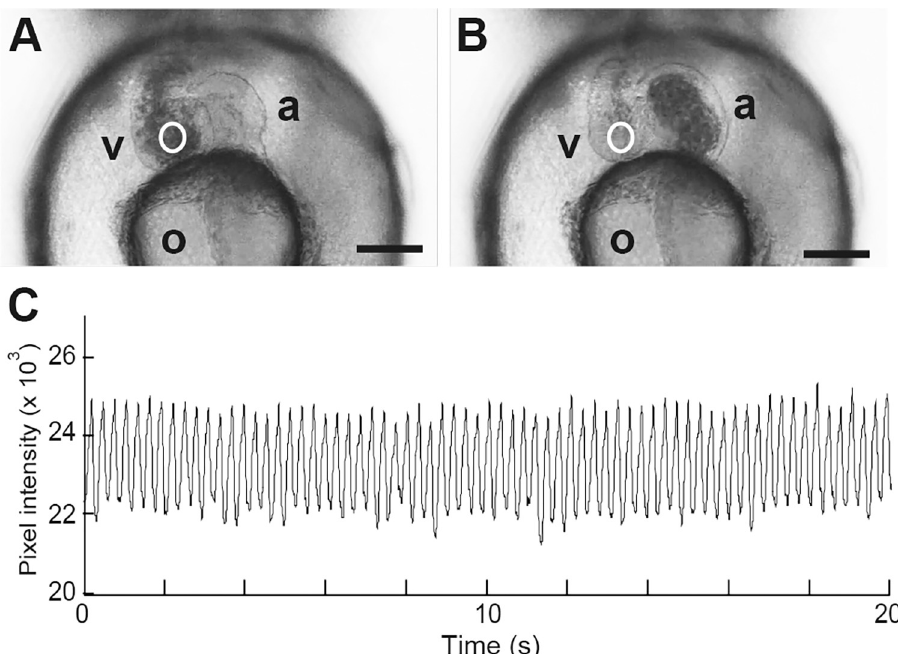
Fig 3. Automated extraction of heart movement in embryos. Sample pictures are at diastole and systole (A and B) in embryonic heart area view. Pixel intensities in the white circular ROI were extracted as numerical data. Twenty seconds of total intensity in white circles throughout the entire series were plotted after being smoothed by the 21-point moving average (C). a, atrium; v, ventricle. o, oil droplets. Scale bars indicated 100 μ m.